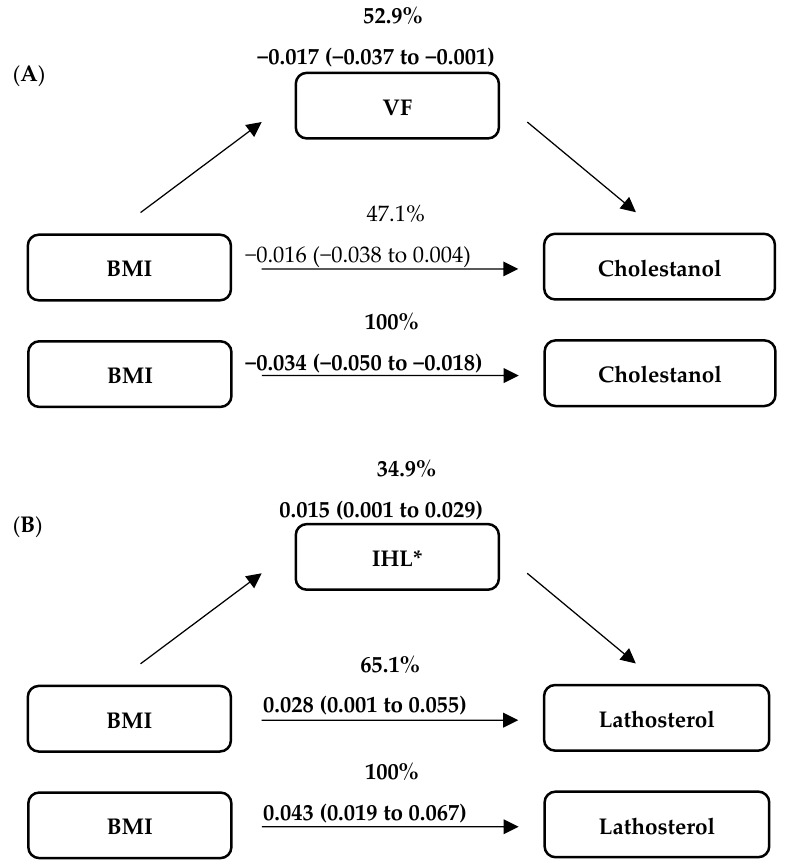
Figure 1. Mediation models of cross-sectional analyses at baseline ( n = 73) for effects of each me- diator on the relationships between BMI (kg/m 2 ) and markers of cholesterol absorption ( A ) and synthesis ( B ), expressed in µ mol/mmol cholesterol. Data are presented as B (bootstrapped 95% CI). Bold figures indicated for significant effects. VT = visceral fat; IHL = intrahepatic lipid content. * Log-transformed data.